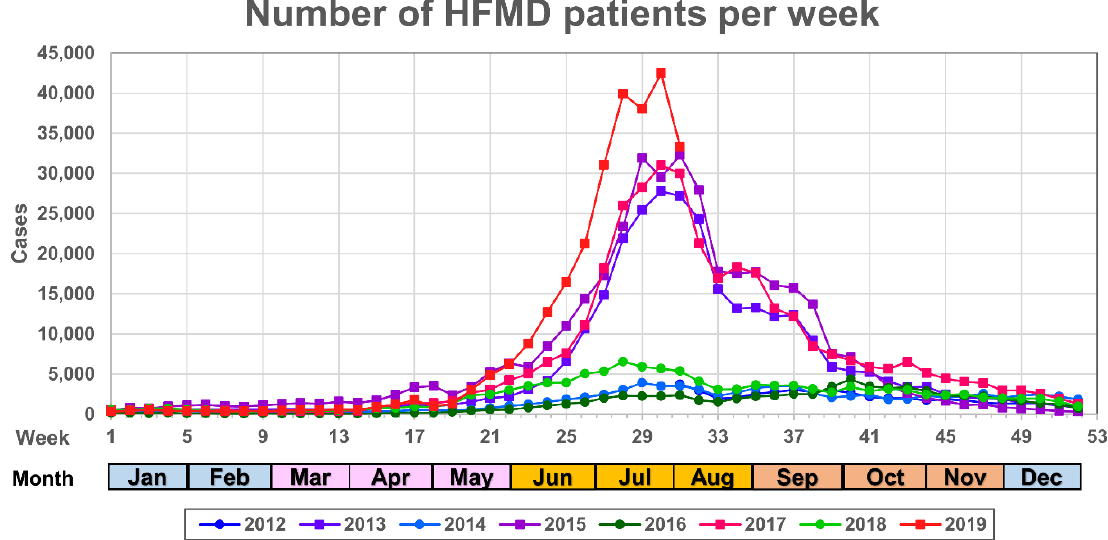
Figure 1. Distribution of the number of hand-foot and mouth disease (HFMD) cases per week in each year between July 2012 and August 2019 in Japan. The horizontal and vertical axes represent the week of the year and the number of cases in Japan for each week, respectively. Months corresponding to the week number are colored by Japanese season as spring (pink), summer (orange), autumn (light brown) and winter (light blue). Colors and marks for each yearly series are presented in the legend at the bottom of the panel.